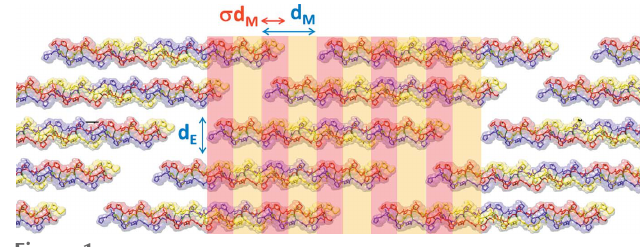
Figure 1 Schematic of the staggered repetition unit of the triple-helix collagen structure. The fiber axis is along the arrow indicating dense (cid:3) d M -wide regions with five nanofibrils overlapping alternately with less dense (1 (cid:2) (cid:3) ) d M -wide regions of one gap and four nanofibrils overlapping.